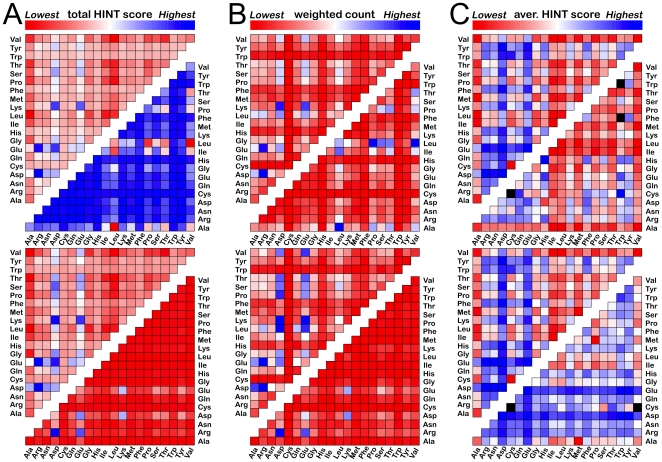
Color heat maps depicting Res1-H2O-Res2 interactions for water molecules found at protein-protein interfaces.All maps are linearly scaled over the maximum range of values for that data set. (A) Total HINT score between waters and Res1/Res2: upper left – all waters in data set (minimum score -71,358, maximum score 114,632); upper right – waters in set with Relevance to neither protein (minimum -41,868, maximum 3,685); lower left – waters in set with Relevance to one protein (minimum -26,470, maximum 50,220); lower right – waters in set with Relevance to both proteins (minimum -3,534, maximum 60,727). (B) Weighted count of Res1/Res2 with water interactions: upper left – all waters in data set (minimum count 0.1, maximum count 242.7); upper right – waters in set with Relevance to neither protein (minimum 0.0, maximum 74.0); lower left – waters in set with Relevance to one protein (minimum 0.1, maximum 113.3); lower right – waters in set with Relevance to both proteins (minimum 0.0, maximum 114.5). (C) Average HINT score (normalized by weighted count) between waters and Res1/Res2: upper left – all waters in data set (minimum average score -601.6, maximum average score 540.5); upper right – waters in set with Relevance to neither protein (minimum -624.3, maximum 483.0); lower left – waters in set with Relevance to one protein (minimum -633.7, maximum 499.7); lower right – waters in set with Relevance to both proteins (minimum -875.1, maximum 680.9). Cells colored black represent cases where the weighted count was zero, and the HINT score normalization yields an undefined value.